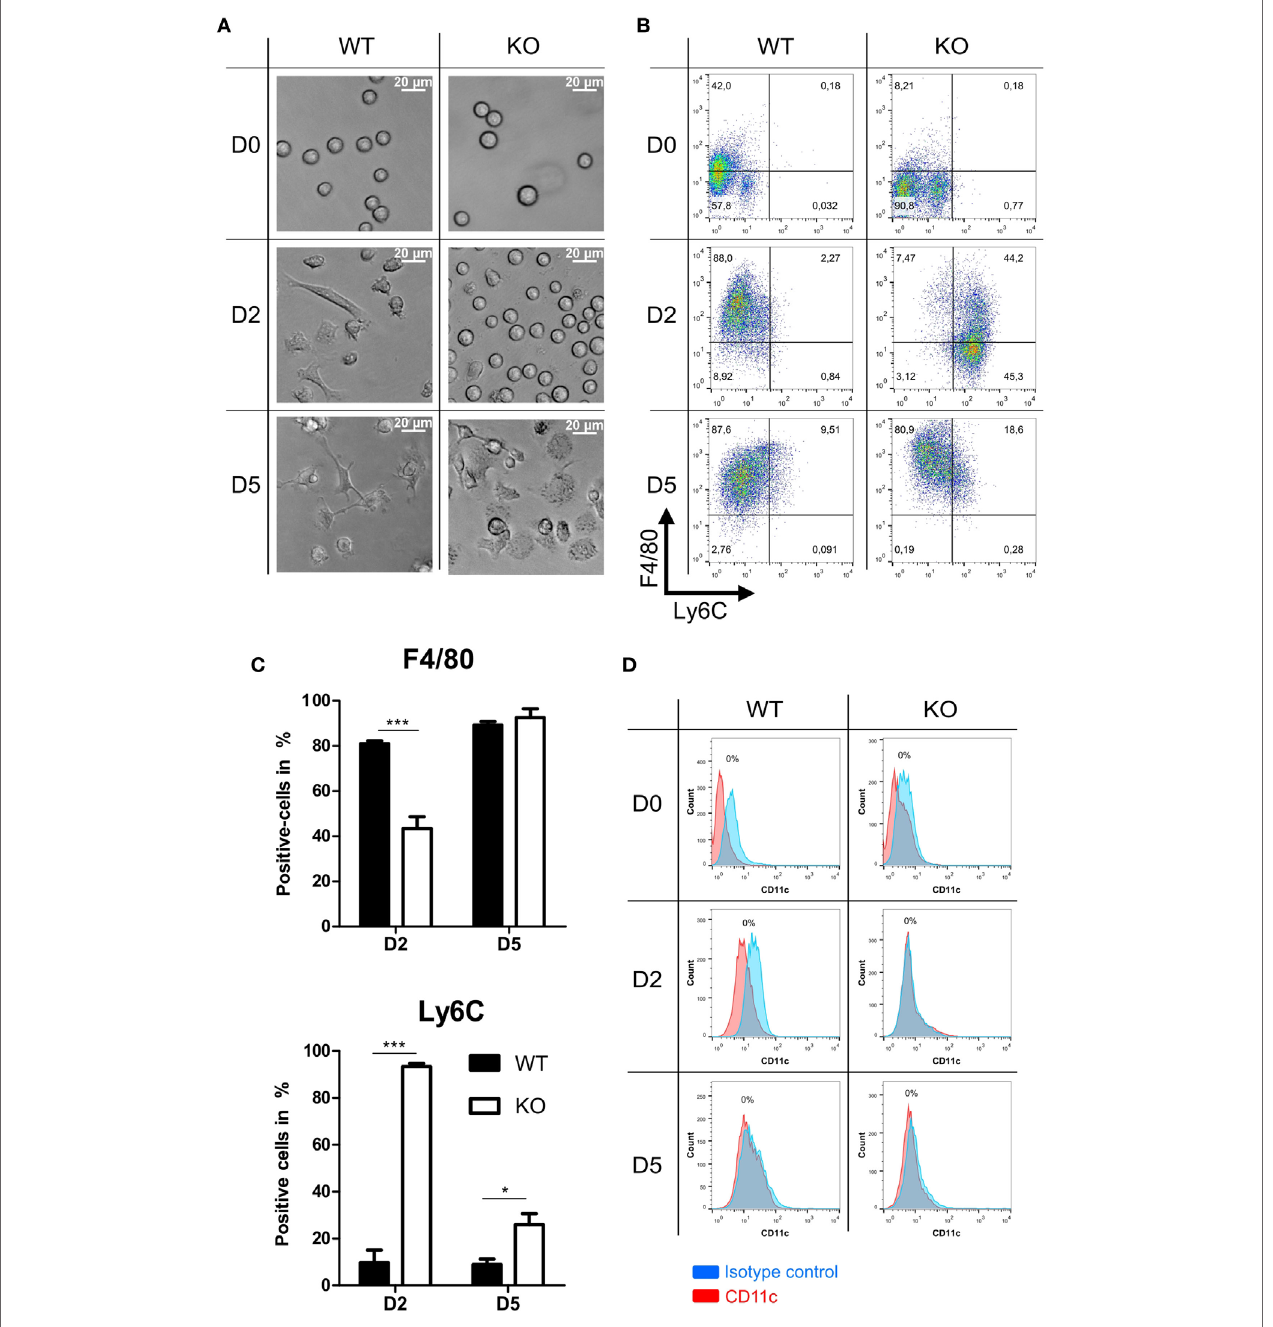
FigUre 2 | Differentiation of peroxisome proliferator-activated receptor- γ -deficient cells shows delayed kinetics. (a) On day 0, 2, and 5 of differentiation, ER-Hoxb8 pool cells were analyzed using light microscopy. A result from one representative experiment out of three performed is shown. (B,c) The expression of Ly6C and F4/80 on day 0, 2, and 5 of differentiation was analyzed using FACS. Dot plots show the results from one representative experiment. (D) The expression of CD11c was investigated using FACS. The bars represent the mean with the SEM of three independent experiments (* p < 0.05, *** p < 0.001) (calculated by using two-way